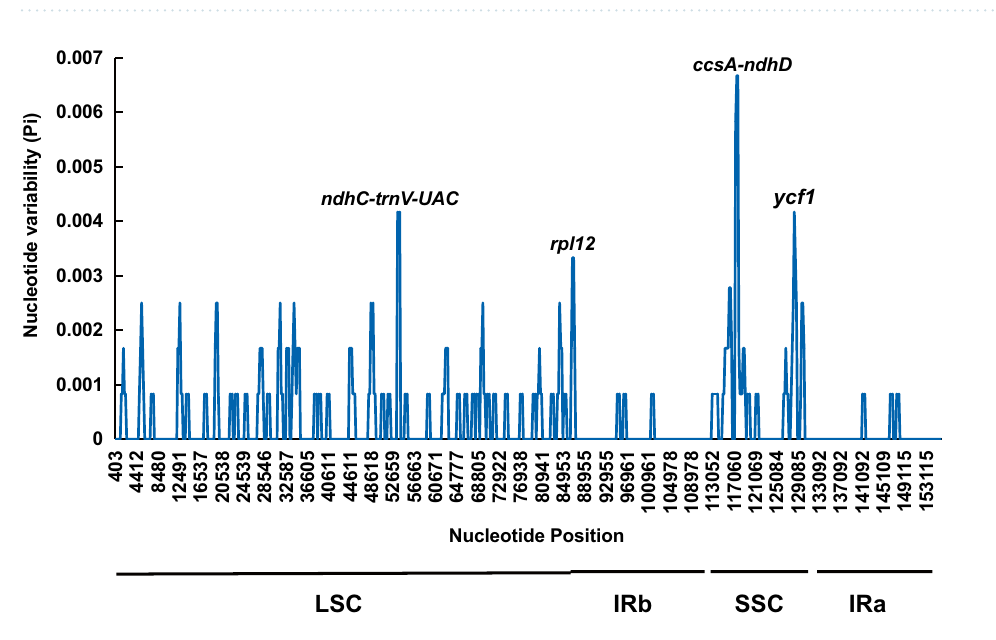
Figure 9. Sliding window analysis of the four Aconitum species chloroplast